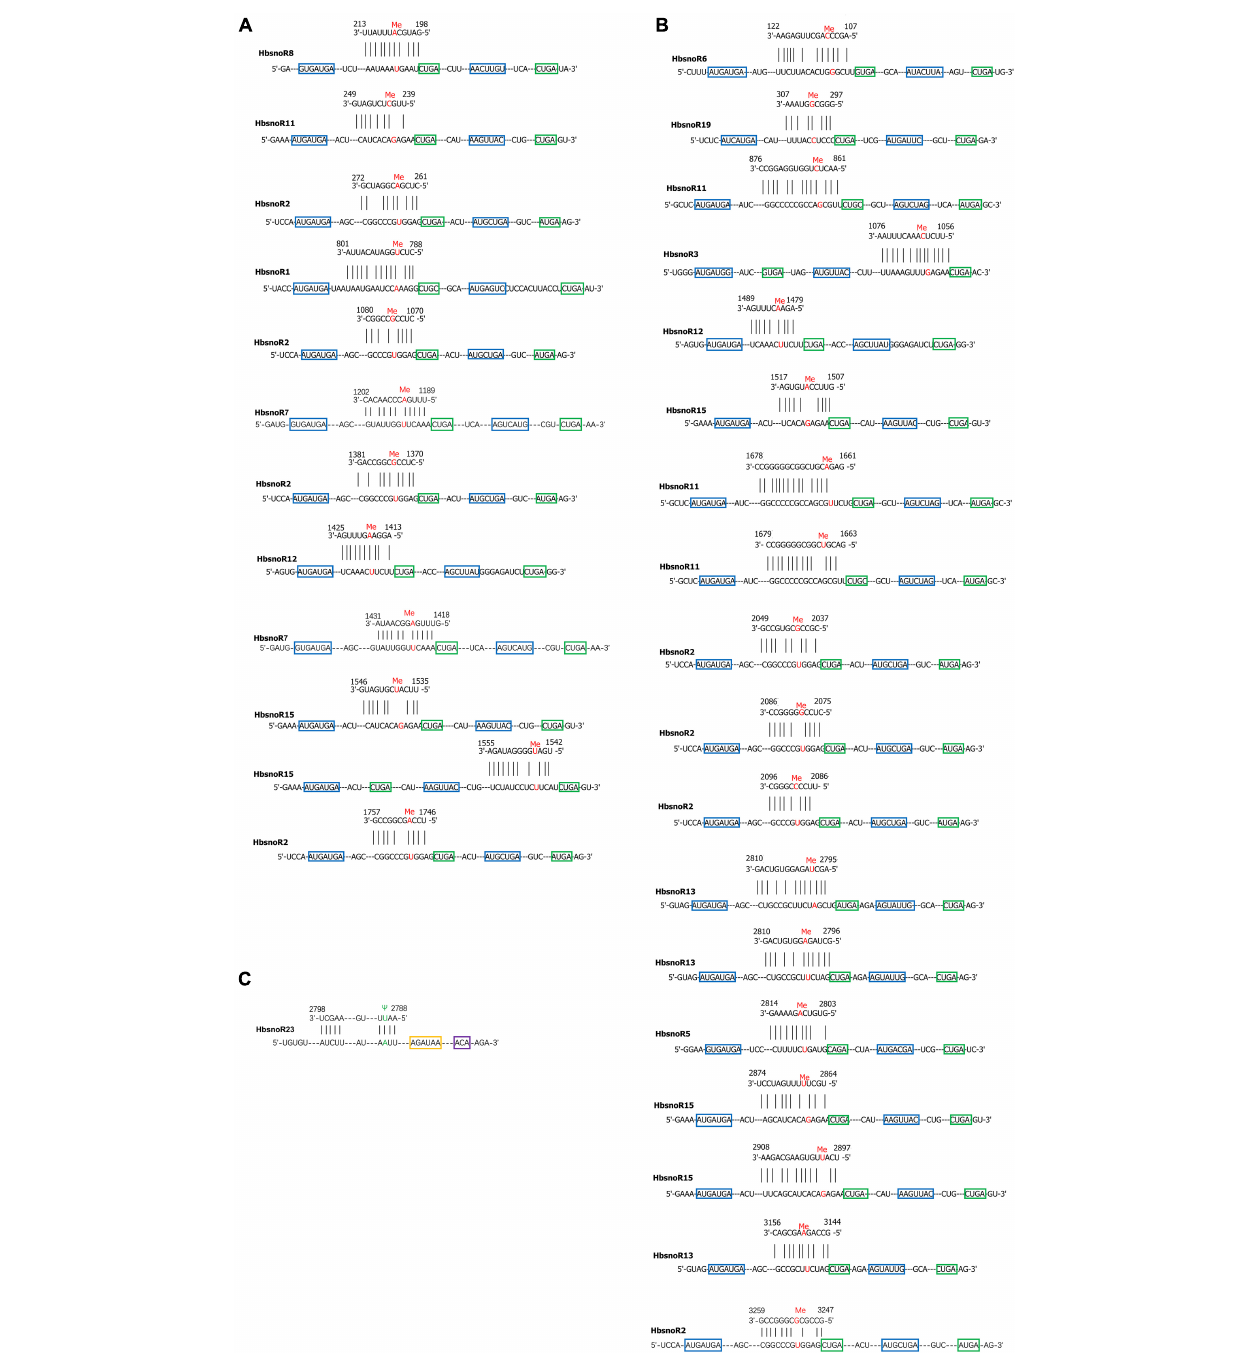
subfamily snoRNA computation according to the pipeline shown in Figure 2